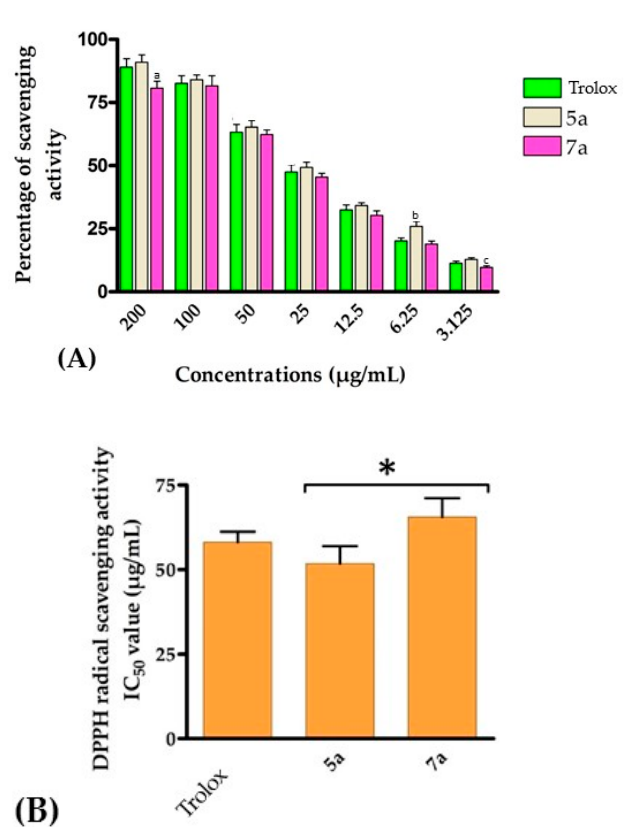
Figure 6. Free radical scavenging activity of compounds 5a , 7a , and Trolox toward DPPH substrate (n = 4). ( A ) Percentage of scavenging activity. ( B ) IC 50 values ( µ g/mL). Data are presented as mean ± SD. a p < 0.05 versus Trolox at concentration 200 µ g/mL, b p < 0.05 versus Trolox at concentration 6.25 µ g/mL, c p < 0.05 versus Trolox at concentration 3.125 µ g/mL,* p < 0.05 versus Trolox for the IC 50